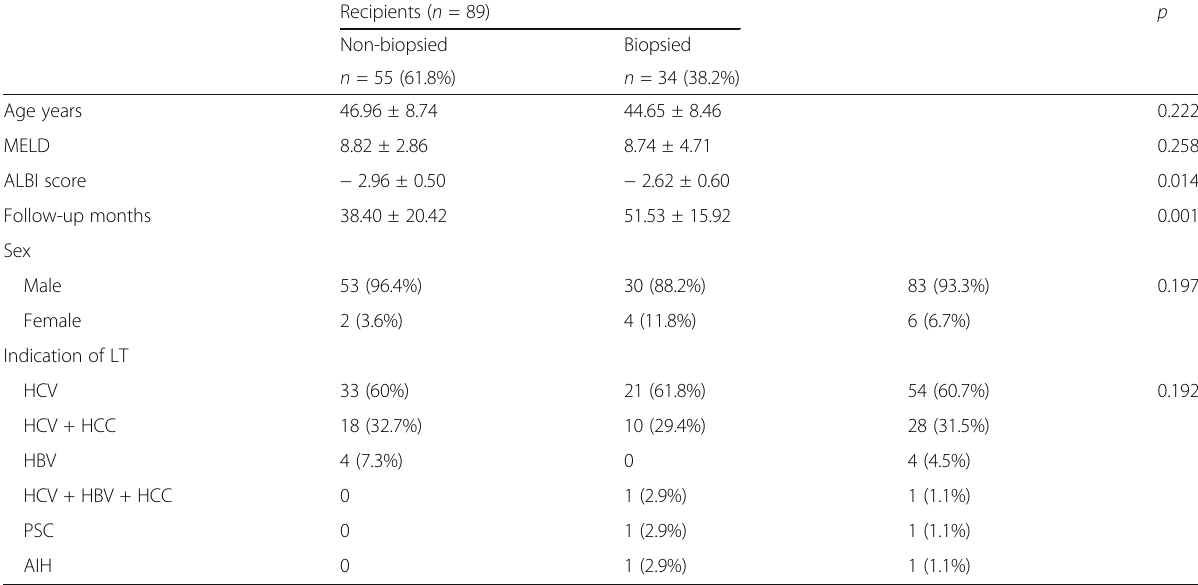
Table 2 Comparison of liver transplant recipients who did and did not undergo liver biopsy Recipients ( n =